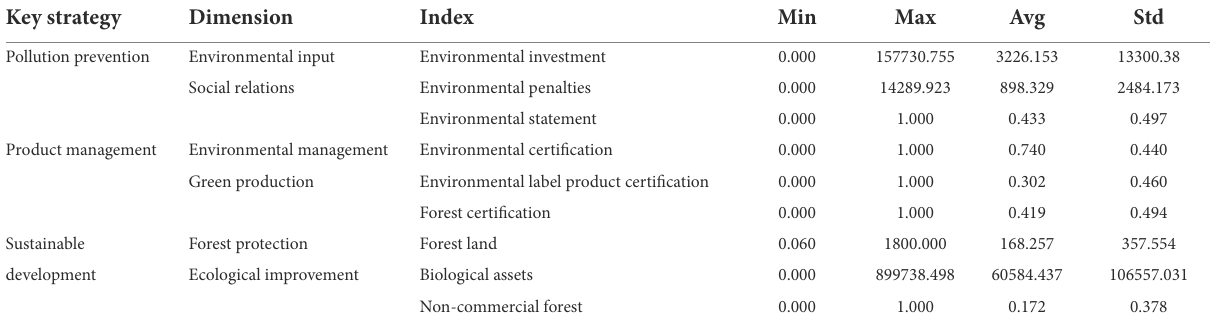
TABLE 2 Data description of each index.